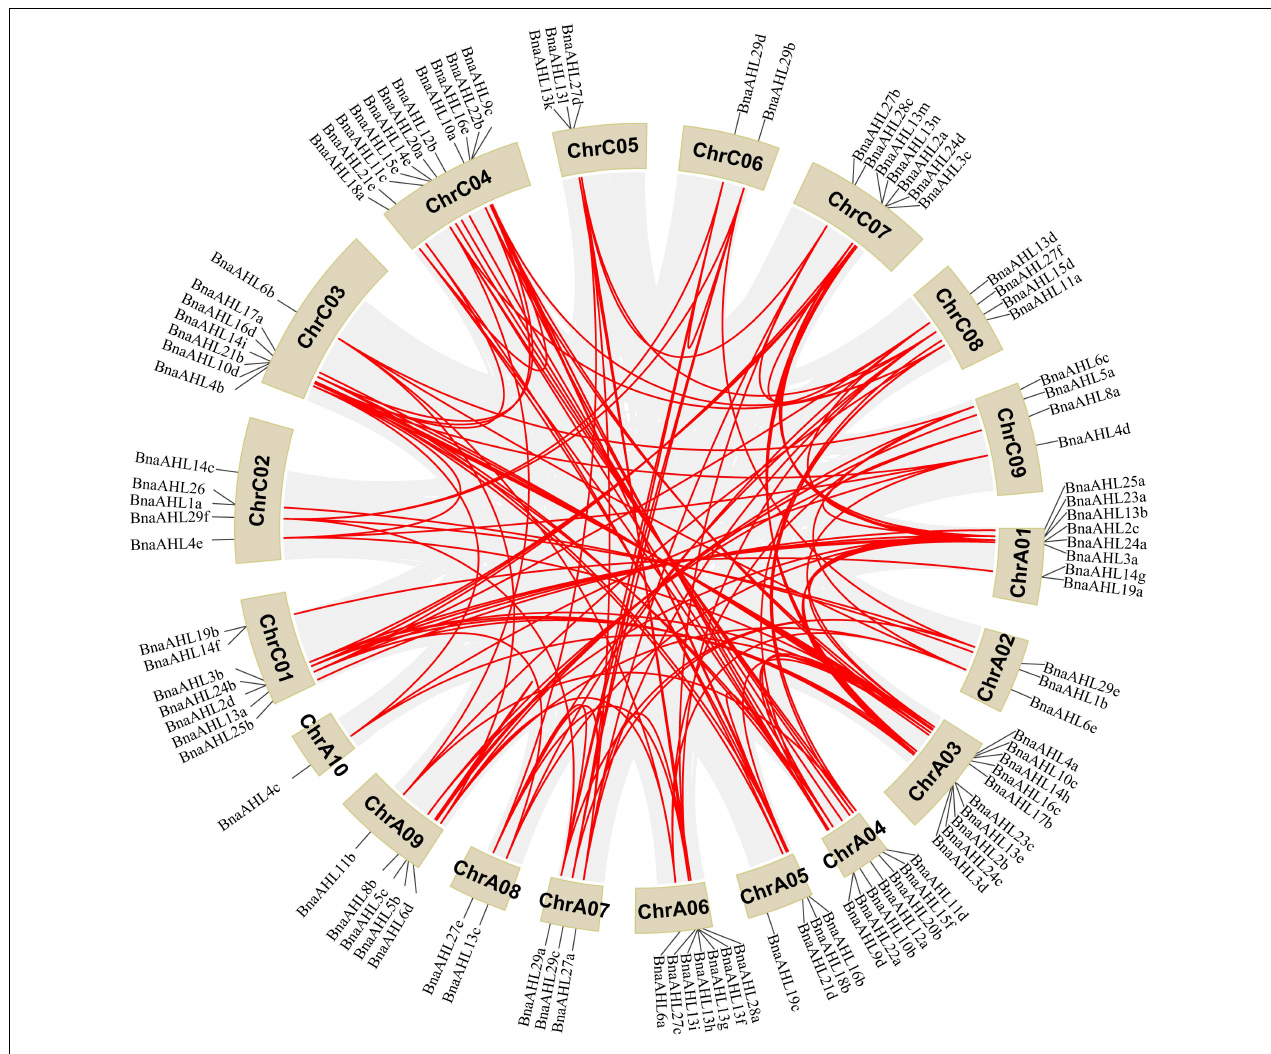
FIGURE 4 | Distribution of BnaAHLs on chromosome. One hundred BnaAHLs are distributed on nineteen different chromosomes of B. napus . In addition, 22 BnaAHLs are not mapped to any chromosomes. The gray lines in the background indicate the collinear blocks in the genomes of B. napus , while the red lines emphasize the segmental duplication of the AHLs . The brown block indicates the chromosome and its length represents the size of the